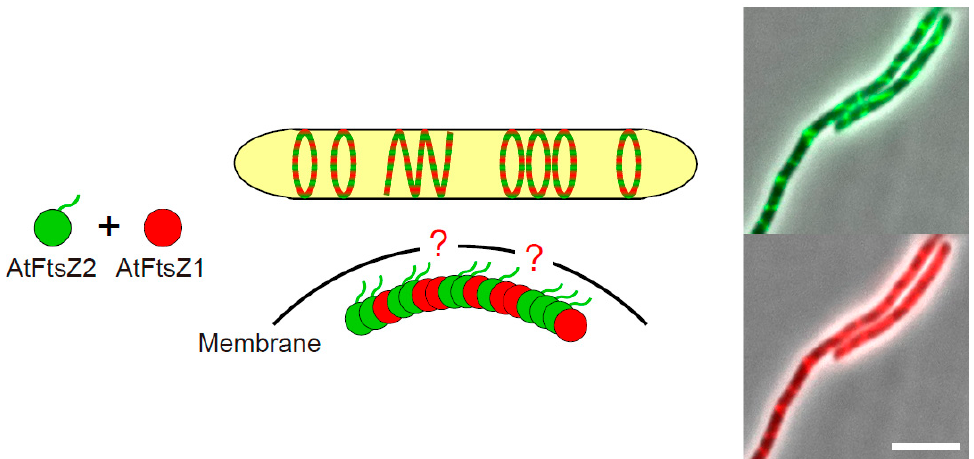
Figure 3. The effects of Arabidopsis chloroplast FtsZ1 on the formation of Z ring-like structures of Arabidopsis chloroplast FtsZ2 in the bacterial heterologous expression system. Schematic illustration of the Z ring-like structures composed of AtFtsZ1 and AtFtsZ2 heterooligomer in E. coli cells, although the mechanism by which the Arabidopsis FtsZ filaments are tethered to the membrane is unclear (indicated by red question marks in the illustration), and its merged microscopic images of phase-contrast and GFP (upper panel), and phase-contrast and mCherry (lower panel) are shown. E. coli cells expressing sfGFP-AtFtsZ2 and mCherry-AtFtsZ1 were grown in L broth (1% bactotryptone, 0.5% yeast extract, 0.5% NaCl) to the stationary phase at 22 °C. Scale bar: 5 µm. To reduce the complexity in the diagram, bundling of the FtsZ filaments was omitted.